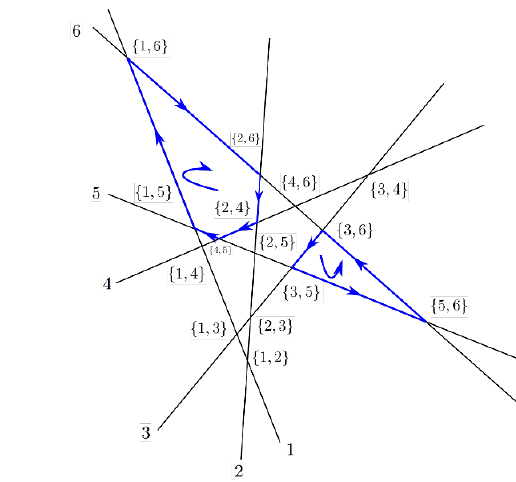
that de(cid:12)nes them, and i